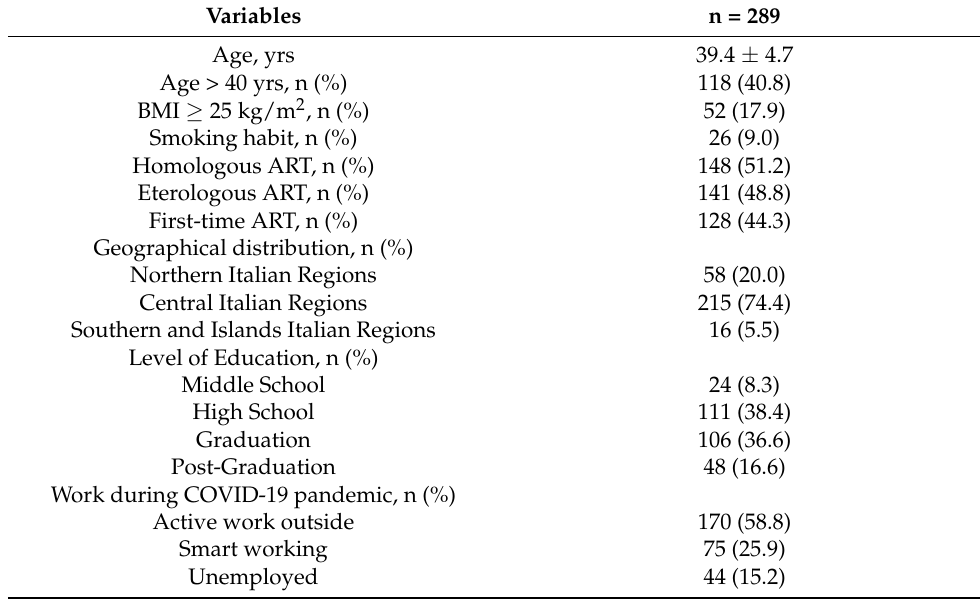
Table 1. Demographic, socio-economic, and clinical characteristics of study